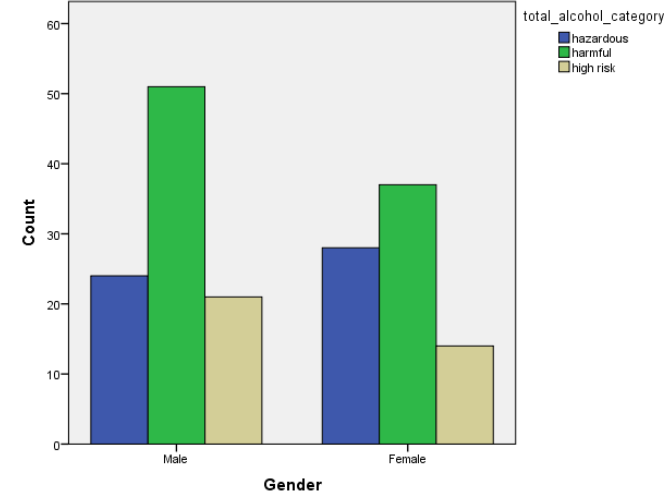
Figure 4. Frequency of tobacco and alcohol consumption depending on gender (female).